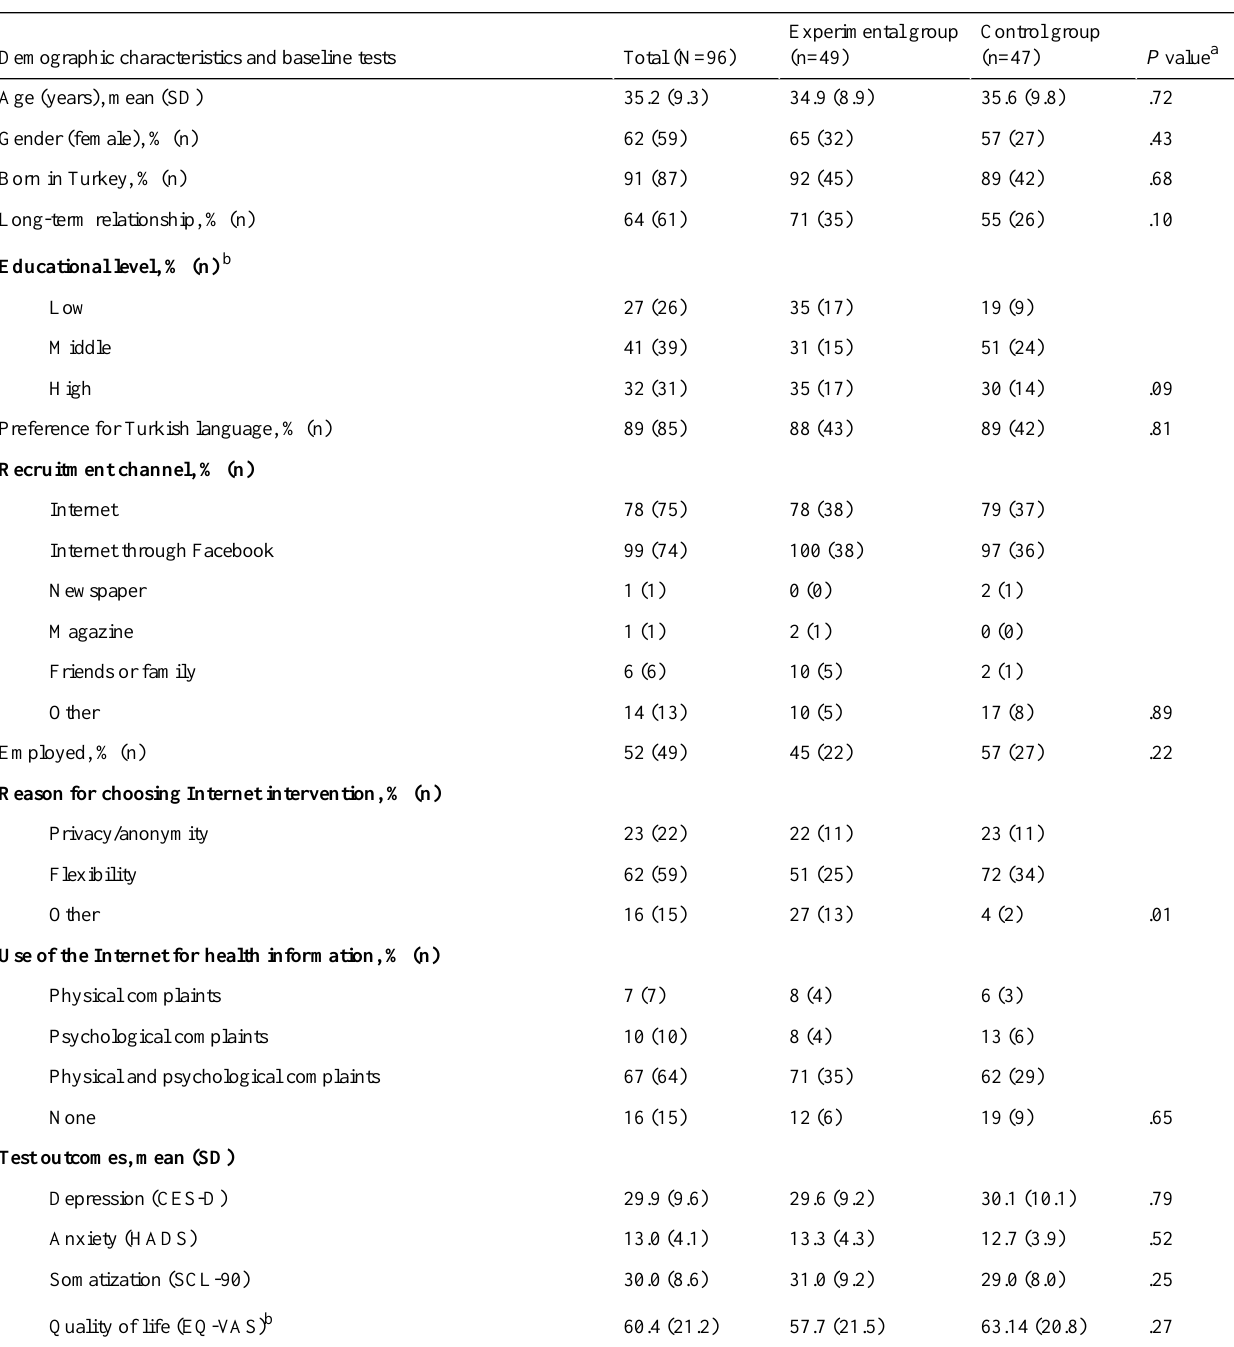
Table 1. Demographic characteristics and baseline test scores at T0